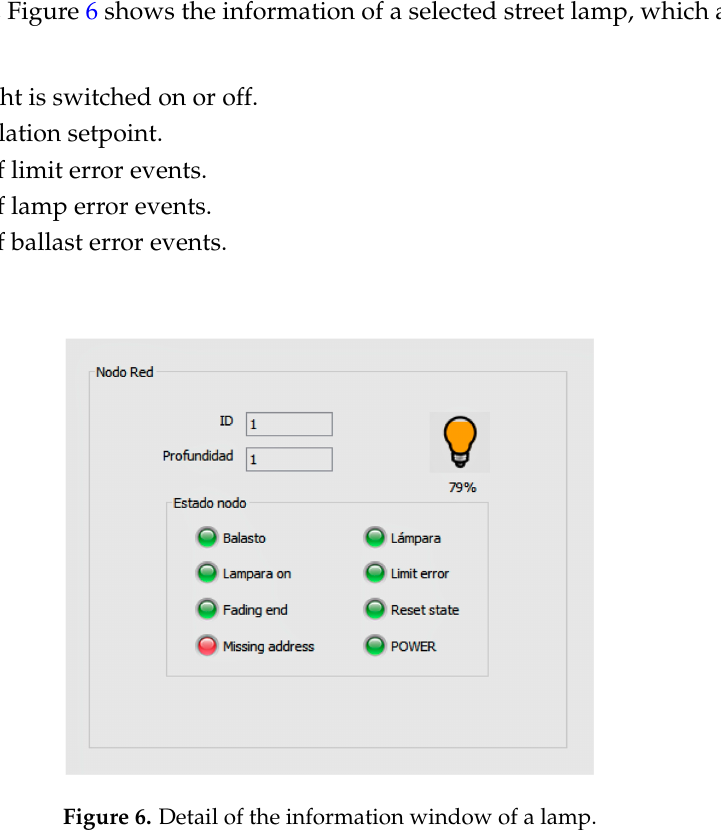
Figure 6. Detail of the information window of a lamp.